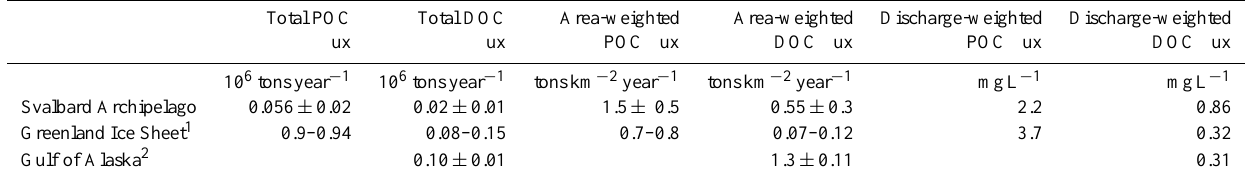
Table 5. Estimated organic carbon flux from Svalbard and its comparison with other pan-Arctic glacier